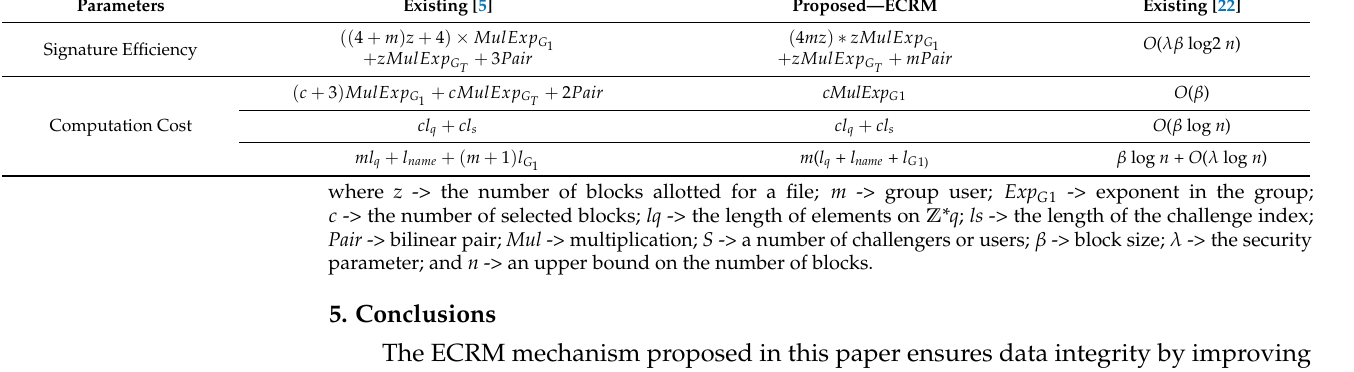
Table 1. Comparison of the proposed with the existing scheme.